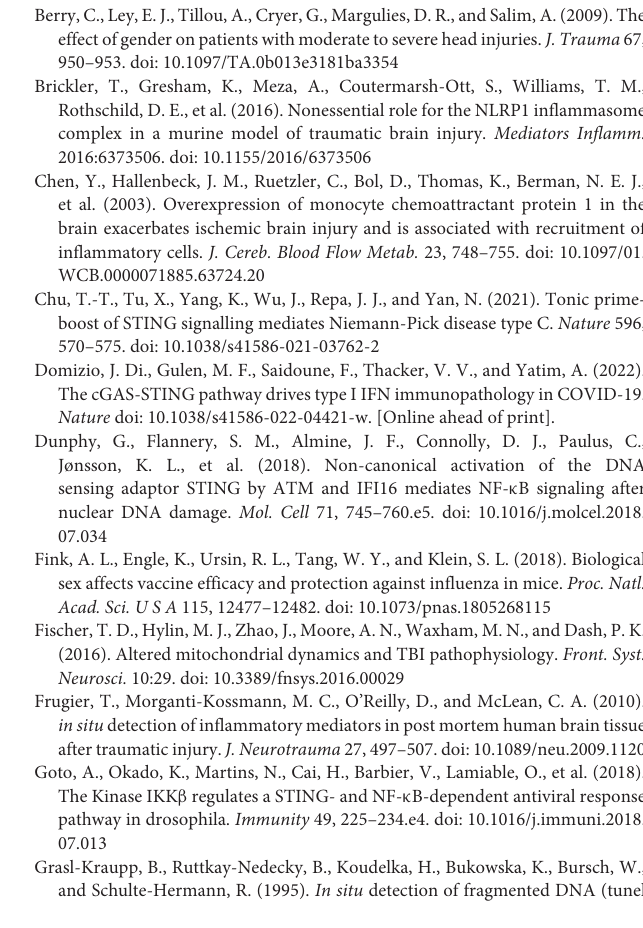
mRNA expression of IFNA4, IFNB1 and Il6 assessed via qPCR 14 dpi or sham surgery for WT and cGAS KO animals. n = 5–7 per group. Data presented as mean ± SEM. Two-way ANOVA used for (A) and (B) , one-way ANOVA for (C) and (E) . * p < 0.05, ** p < 0.01, ∗∗∗ p < 0.001, ∗∗∗∗ p < 0.0001. Supplementary Figure 3 | Comparison of cytokine expression between ipsilateral sham and contralateral injured tissue. mRNA expression of (A) Il6 and (B) Il10 2 h after surgery from the cortices of sham and CCI-injured WT animals. Gene expression was normalized to GAPDH. n = 5–6 per group. Data presented as mean ± SEM. Supplementary Figure 4 | Loss of STING attenuates cytokine and ISG response after injury. (A–C) Cytokine and interferon-stimulated gene (ISG) expression profiled 24 h after CCI from the contralateral and ipsilateral hemispheres of STING − / − and WT mice. Cortical expression of (A) CXCL10 , (B) IRF7 , (C) IFIT1 , (D) IFIT3 , (E) STAT1 , (F) STAT2 , (G) RIG-I , and (H) IFIH1 in WT and STING KO animals 24 h post-TBI. Gene expression was normalized to GAPDH. n = 5–6 per group. Data presented as mean ± SEM. * p < 0.05, ** p < 0.01, ∗∗∗ p < 0.001, ∗∗∗∗ p < 0.0001. Supplementary Figure 5 | Microglia upregulate cGAS and STING after injury. mRNA expression of (A) cGAS and (B) STING in isolated microglia collected 2- and 24 h after CCI or sham surgery. (C) mRNA expression of STING in non-adherent (non-microglia) cells remaining after microglia isolation 2- and 24 h after CCI or sham surgery. Gene expression was normalized to GAPDH and is relative to sham for each timepoint. n = 3–4 per group with pooled pairs of mice representing an n. Data presented as mean ± SEM. ** p <